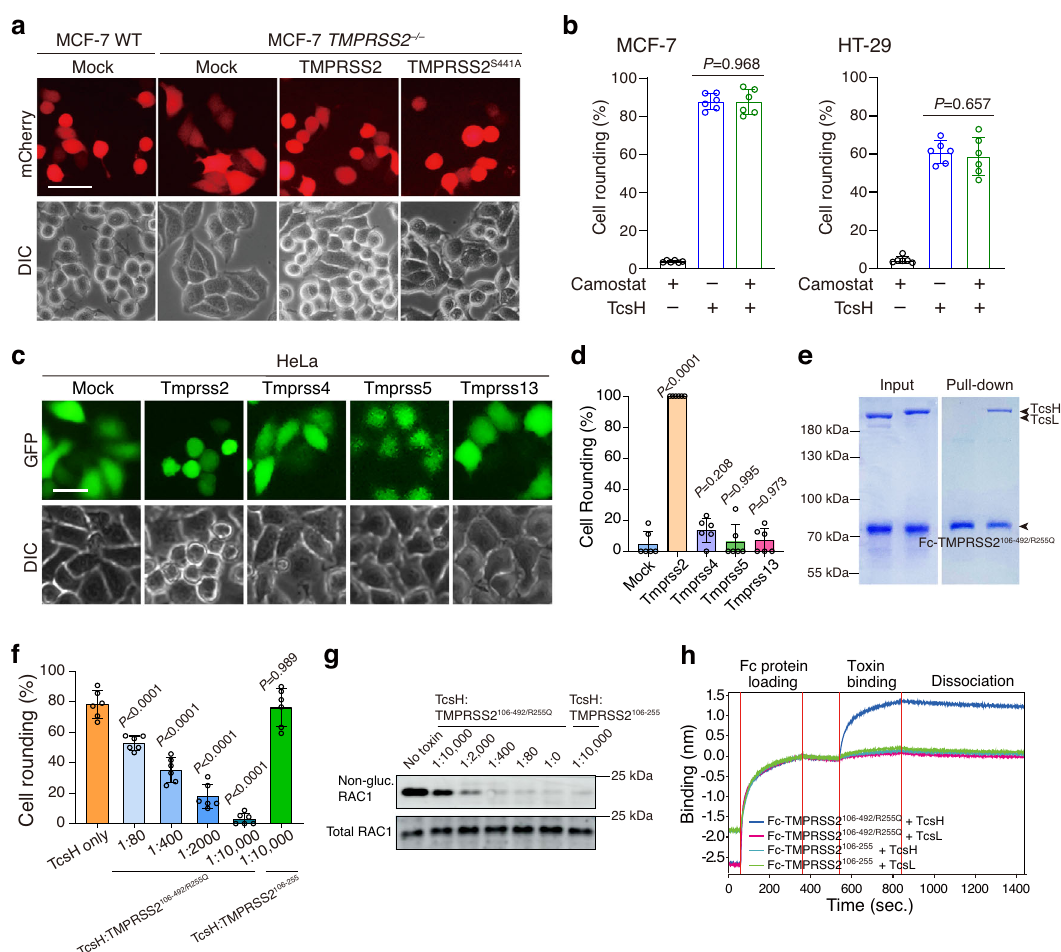
Fig. 3 | TMPRSS2 is a cellular receptor for TcsH. a Ectopic expression of either TMPRSS2orTMPRSS2 S441A restoredthesusceptibilityoftheMCF-7 TMPRSS2 ‒ / ‒ cells to TcsH. Red fl uorescence (mCherry) indicates the transfection. The MCF-7 cells weretreatedwith10pMTcsHfor3.5h.Thescalebarrepresents50 μ m. b TheMCF- 7 or HT-29 cells were pre-incubated with or without 100 μ M Camostat (12h) and then exposed toTcsH (10pM for MCF-7 and 100pM for HT-29, 3.5h).Percentages ofroundedcellswerequanti fi edandplottedonthebarcharts. c Ectopicexpression of a mouse Tmprss2, but not other Tmprss proteins, enhanced sensitivity of HeLa cell to TcsH (2nM, 3h). The scale bar represents 50 μ m. d The percentages of